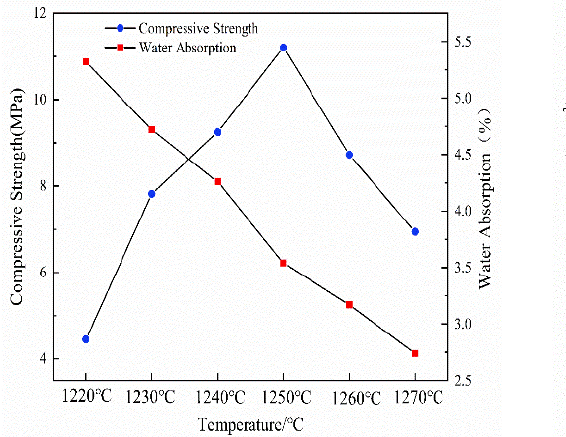
( b ) Figure 5. XRD patterns of raw materials and ceramsites at different sintering temperatures: ( a ) MTs, SS and CG; ( b ) ceramsites. It can be seen in Figure 5b that cordierite (Mg 2 Al 4 Si 5 O 18 ), magnesia – alumina spinel (MgAl 2 O 4 ), and magnesium silicate (MgSiO 3 ) are the main mineral phases of ceramsites. We can conclude that a series of complex glass crystal reactions occurred in the sintering process. The main crystal phase cordierite in ceramsite is the reaction of MgO decomposed from the MgCO 3 in the MTs with Al 2 O 3 in SS and CG to form magnesia – alumina spinel (MgAl 2 O 4 ); then, the magnesium-aluminum spinel reacts with quartz (SiO 2 ) to form